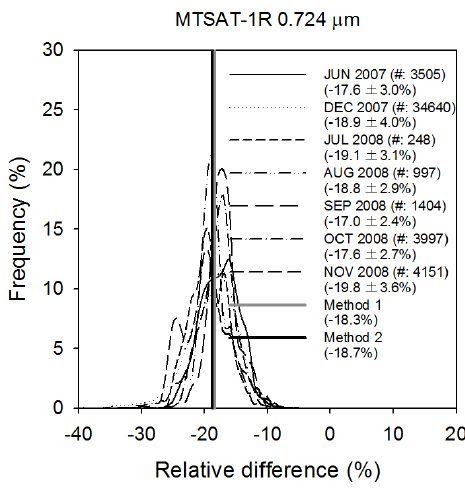
Fig. 13. Same as in Fig. 9 but for the MTSAT-1R 0.724-µm channel (Method